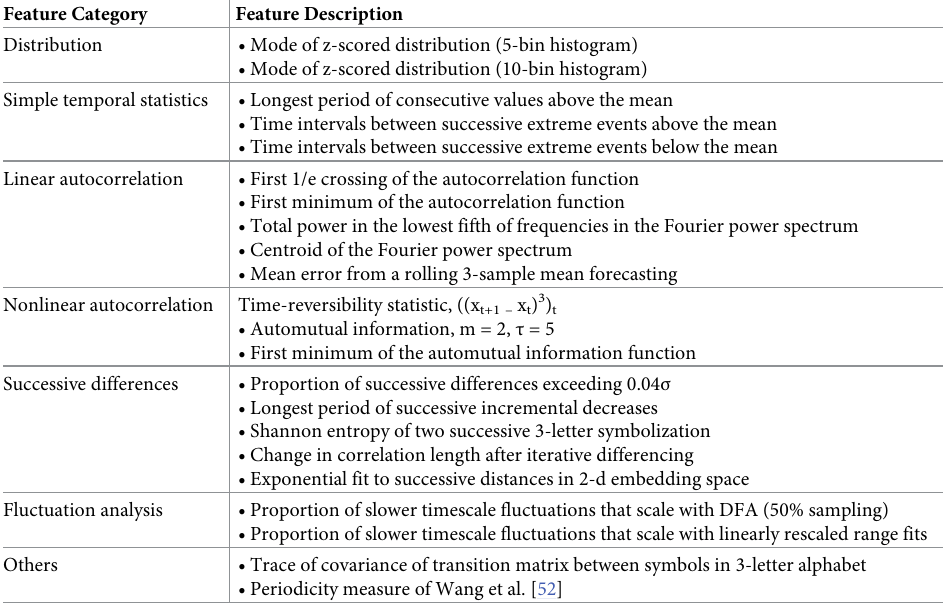
Table 1. Description of features extracted from each physiological signal as time-series